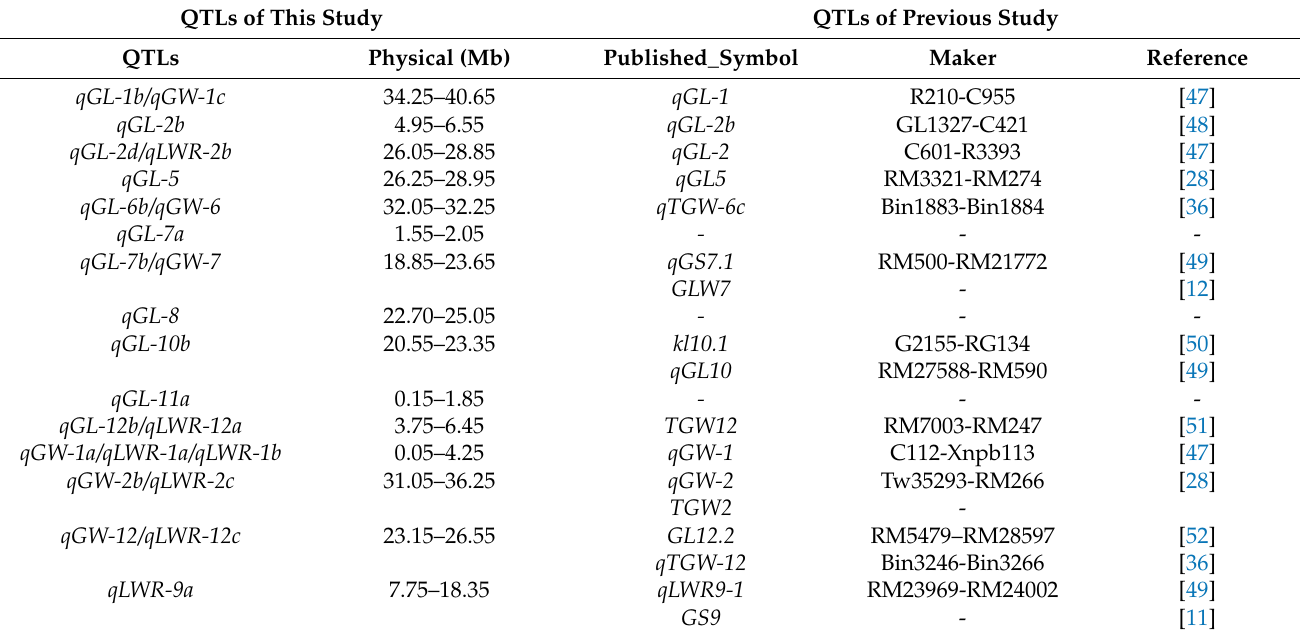
Table 2. Comparison of grain shape related QTLs with previous